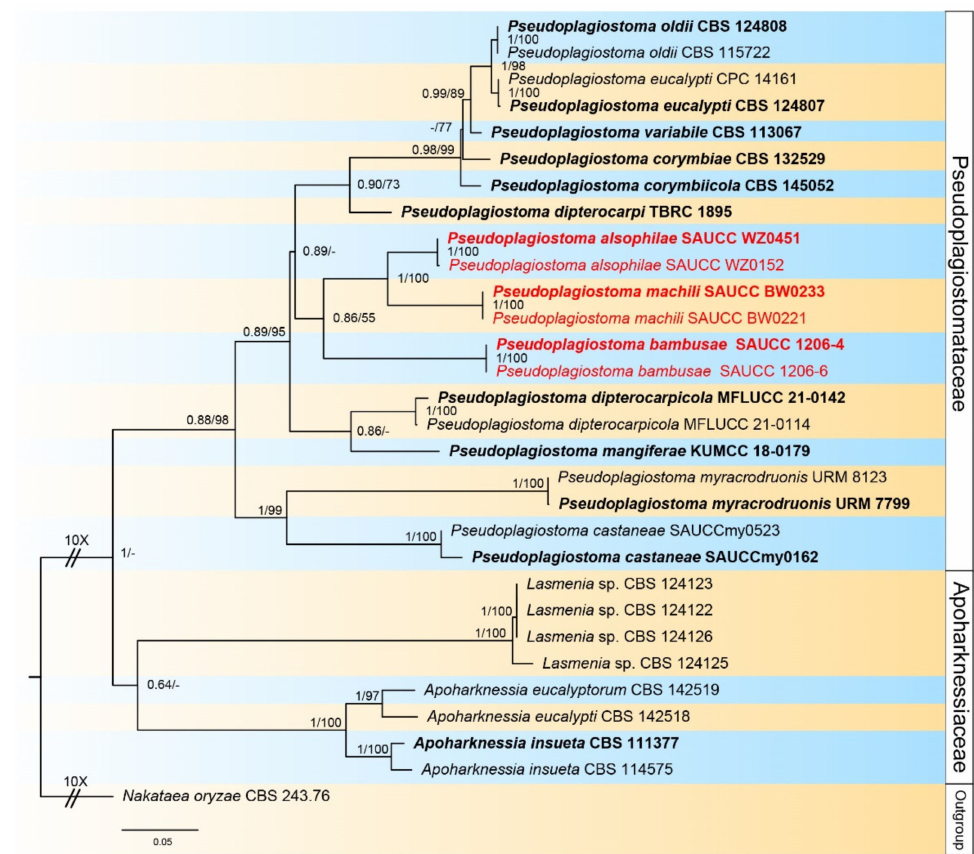
Figure 1. A phylogram of the Pseudoplagiostomataceae and Apoharknessiaceae , based on a concatenated ITS, LSU, rpb2 , tef1 α , and tub2 sequence alignment, with Nakataea oryzae (CBS 243.76) as outgroup. BI posterior probabilities and maximum likelihood bootstrap support values above 0.60 and 50% are shown at the first and second position, respectively. Ex-type cultures are marked in bold face. Strains obtained in the present study are in red. Some branches are shortened for layout purposes—these are indicated by two diagonal lines with the number of times. The scale bar at the left–bottom represents 0.05 substitutions per